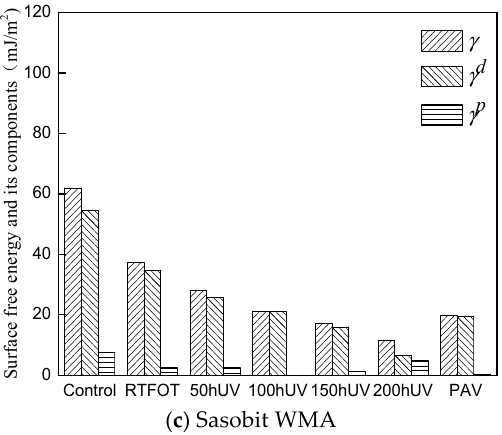
Figure 4. Influence of aging on SFE of aged asphalt.